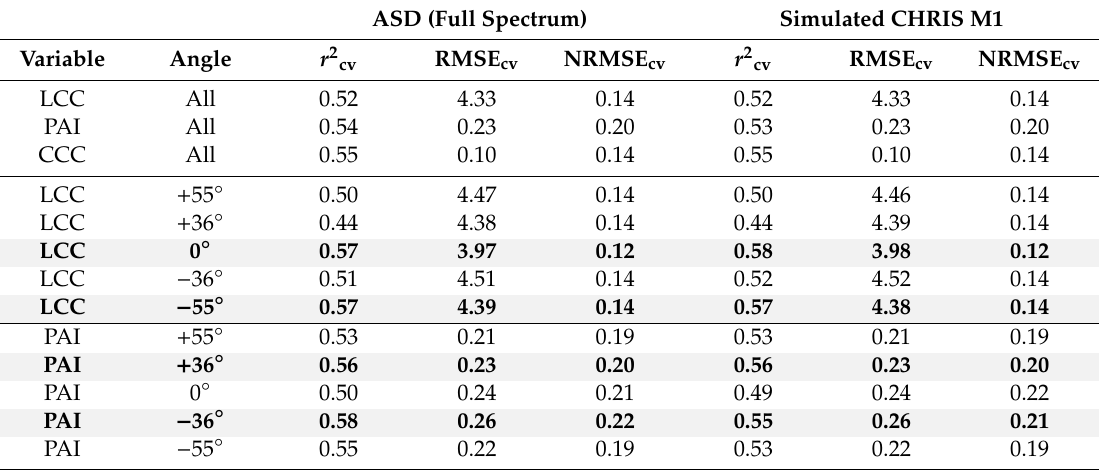
Table 5. ROSAVI model performance for plot scale data averaged over all sites and VZAs. RMSE cv units: LCC ( µ g / cm 2 ); PAI (unitless); CCC (g / m 2 ). NRMSE cv = RMSE cv / range of measured data. The top angle-based results are highlighted and